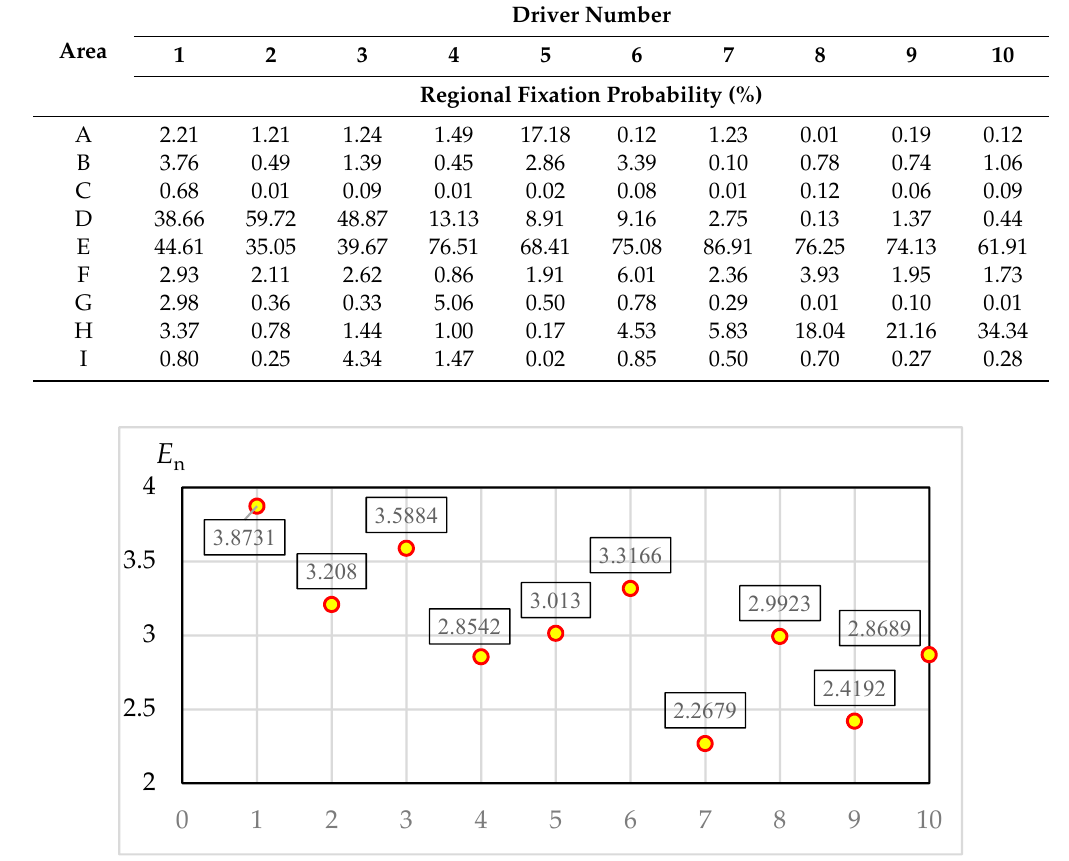
Table 5. Statistics of the fixation probability of each region.